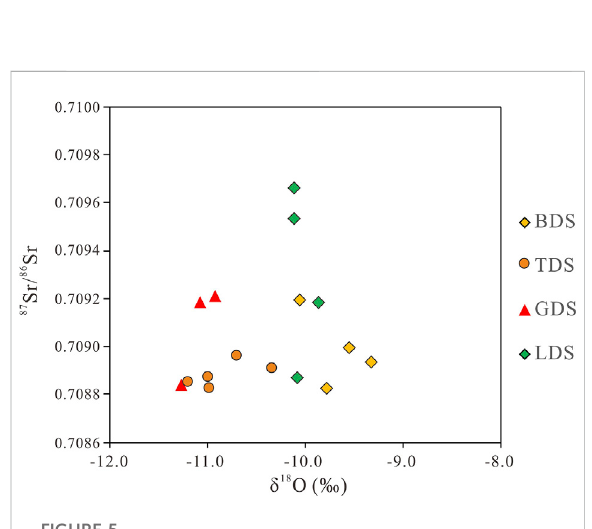
FIGURE 5 The cross-plot of strontium and oxygen isotope for different types of lithofacies in the Xiaoerbulake Formation.